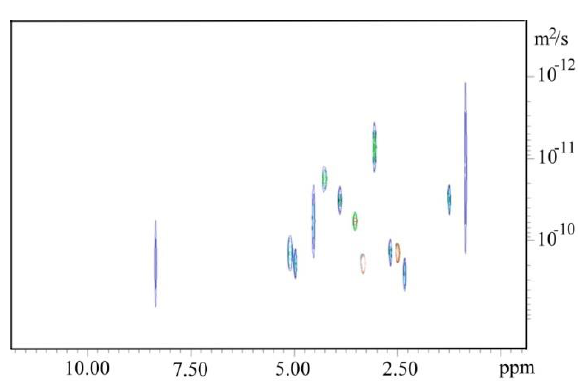
Figure 2. Typical 13 C CP/MAS NMR spectrum of cellulose